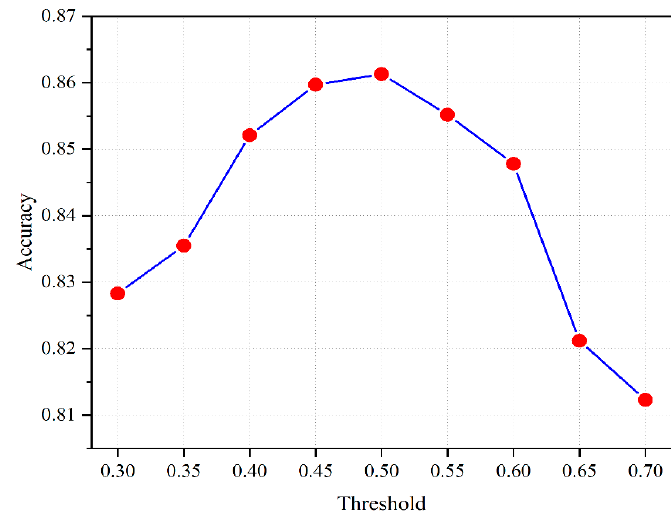
Figure 5. Testing accuracy of different thresholds.